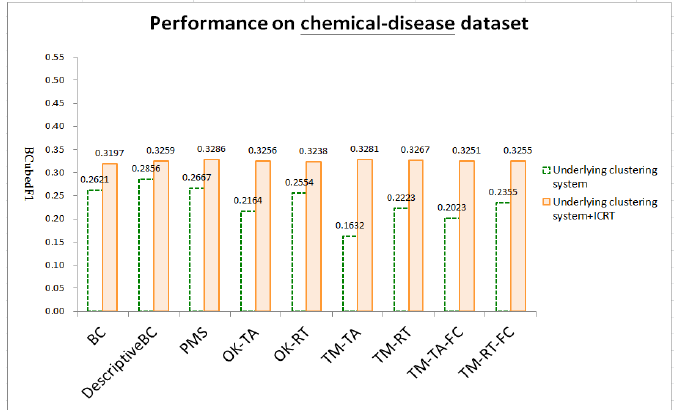
Figure 5. Test results on the chemical-disease dataset.